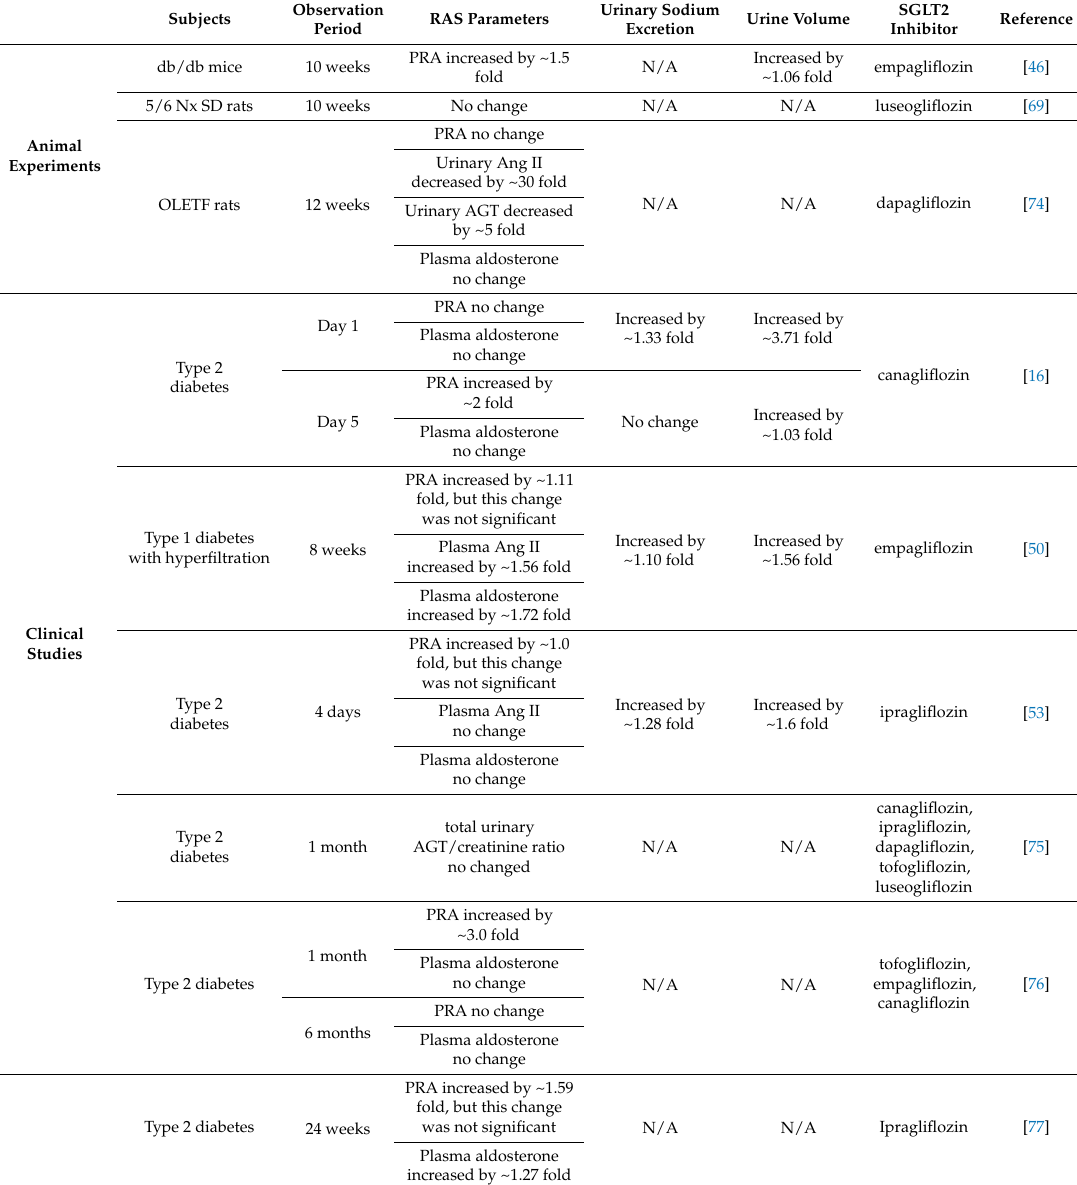
Table 2. Relationship between SGLT2 inhibitor-induced changes in urine volume and urinary sodium excretion and RAS